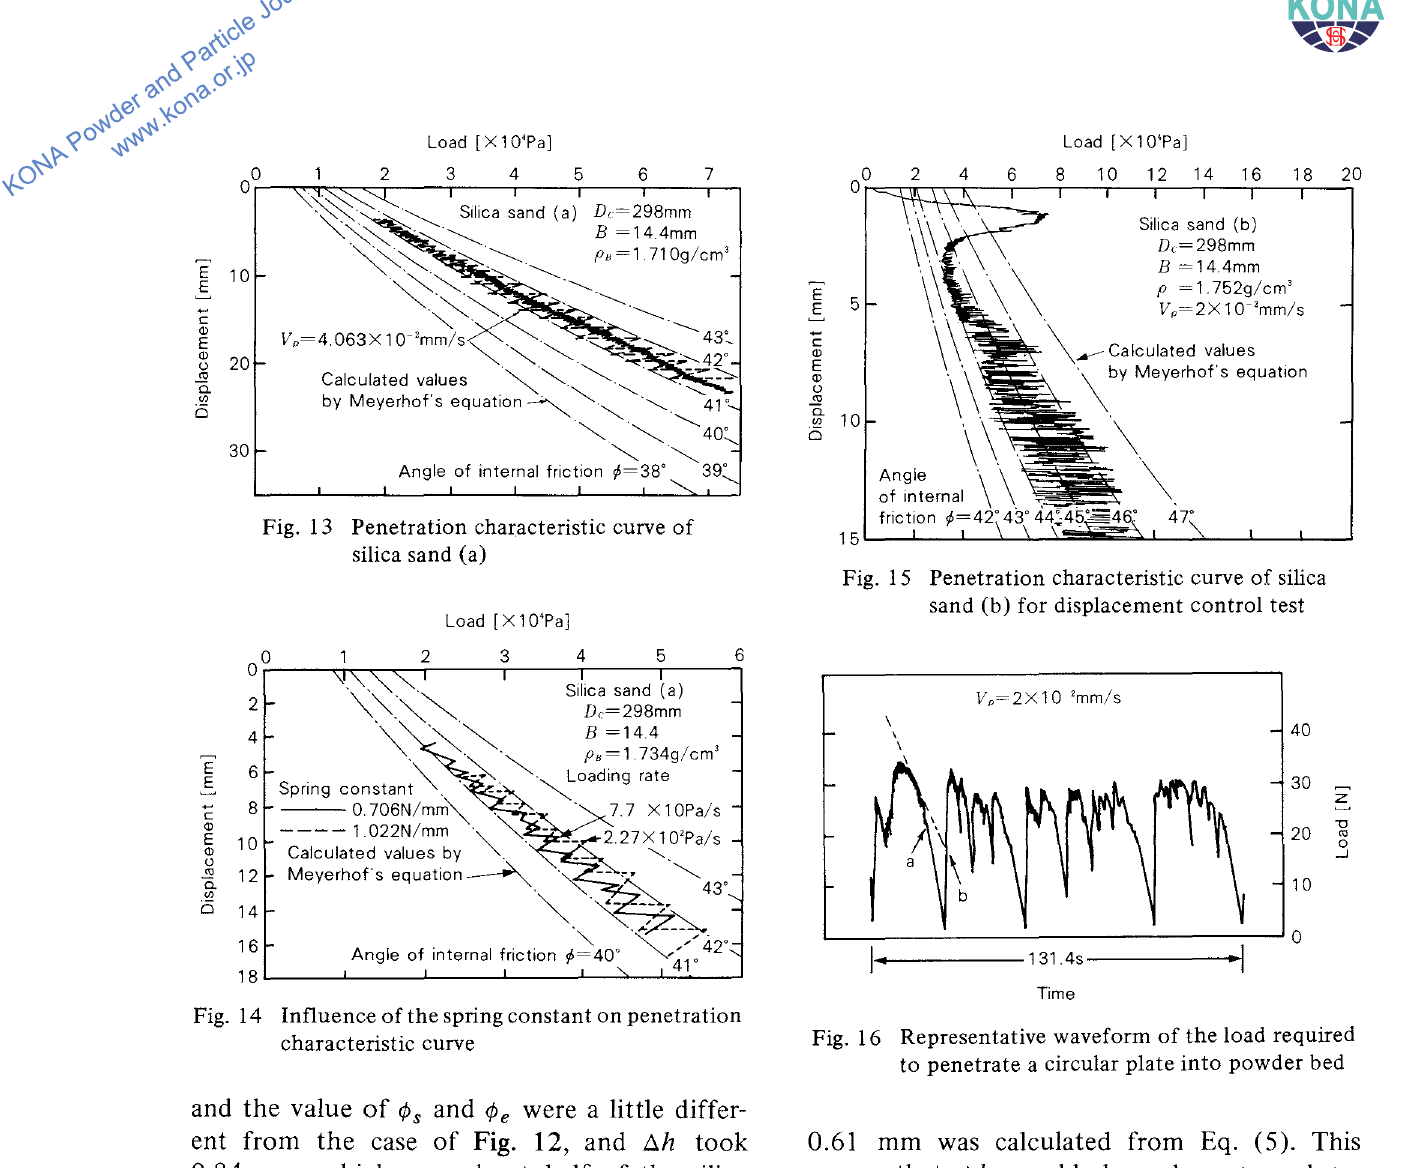
Fig. 14 Influence of the spring constant on penetration characteristic curve